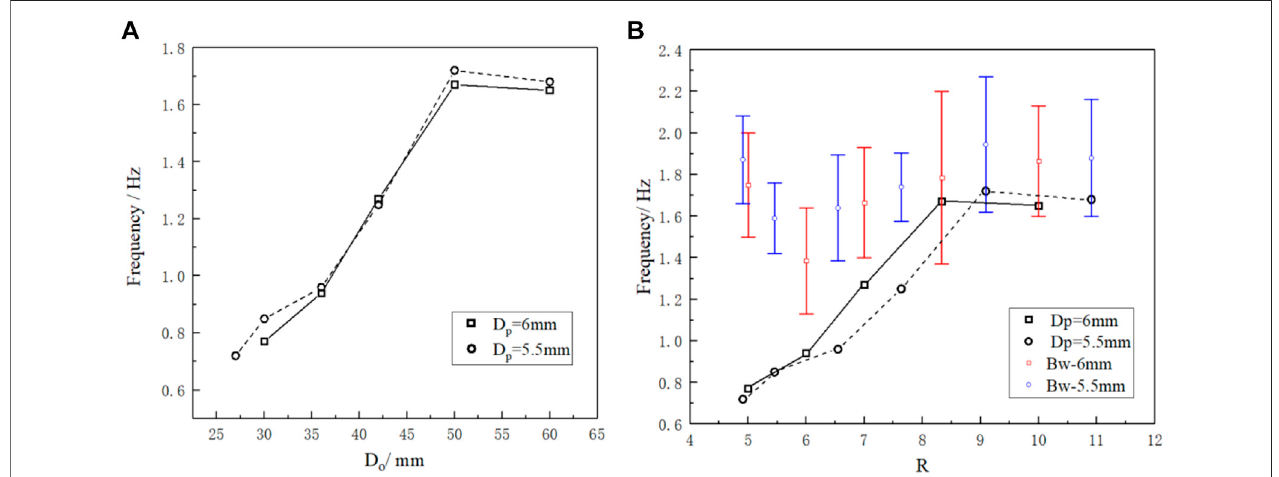
FIGURE 10 | Fluctuation frequency at different ori fi ce